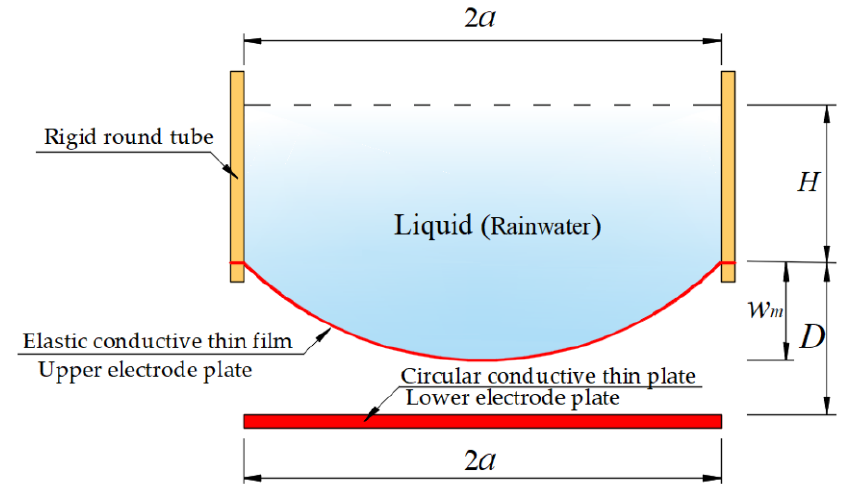
Figure 9. Sketch of rain gauges based on membrane deflection and non-parallel plate capacitor. For the first type of rain gauge, the maximum deflection w m of the deflected circular membrane can be directly measured, for example, by a non-contact laser displacement sensor. Figure 10 shows a scatter diagram describing the relationship between the height H of the rainwater in the storage container and the maximum deflection w m of the deflected circular membrane, where the values of the scatter points are calculated using the closed-form solution given in Section 2, and then to fit the curve H = 44.34 − 11.23 w m + 0.7323 w m2 . Therefore, with the measured values of the maximum deflection w m , the corresponding values of the height H of the rainwater in the storage container can be determined using the analytical expression H = 44.34 − 11.23 w m + 0.7323 w m2 . parallel plate capacitor is given by [13,32].